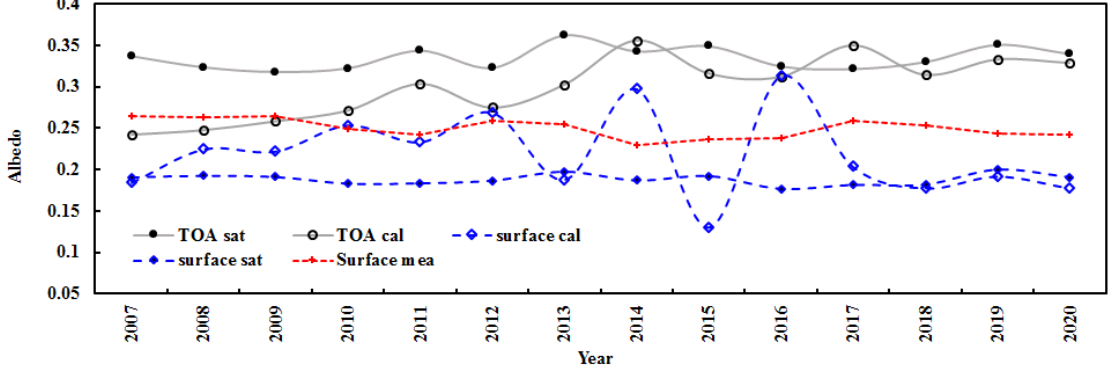
Figure 13. Annual mean albedos during 2007–2020, calculated and satellite-retrieved at the TOA and the surface and measured at the surface (mea) under all-sky conditions at the Qomolangma site. The albedo increases at the TOA in 2007–2020 may be caused by decreases in (1) ab- During 2007–2020, the model-computed and satellite-derived annual albedos increased by 2.85% and 0.27% per year at the TOA, respectively, and decreased by 1.10% and 0.04% per year at the surface, respectively. The measured surface albedos also decreased by 0.50% per year. The annual mean albedos were 0.301 (0.243–0.356) and 0.209 (0.131–0.313) at the TOA and the surface for the model-computed values, 0.335 (0.318–0.362) and